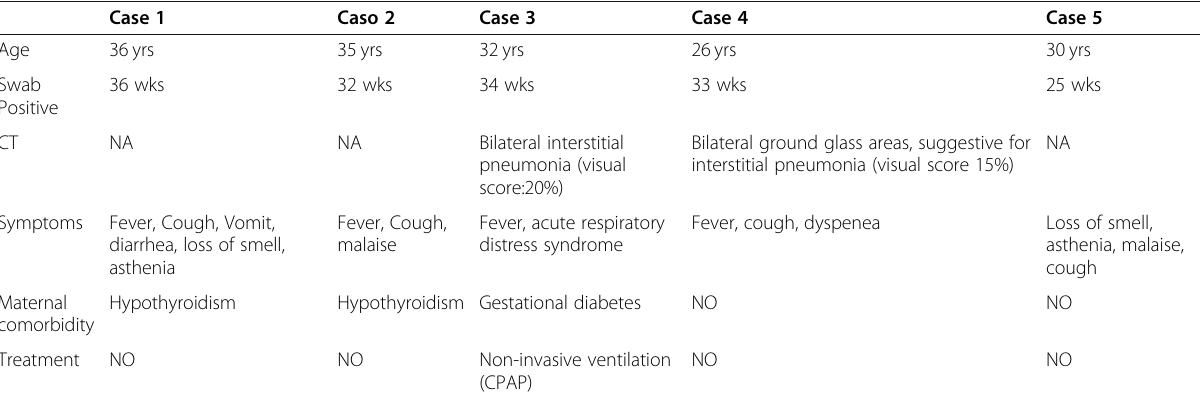
Table 1 Clinical data of pregnant